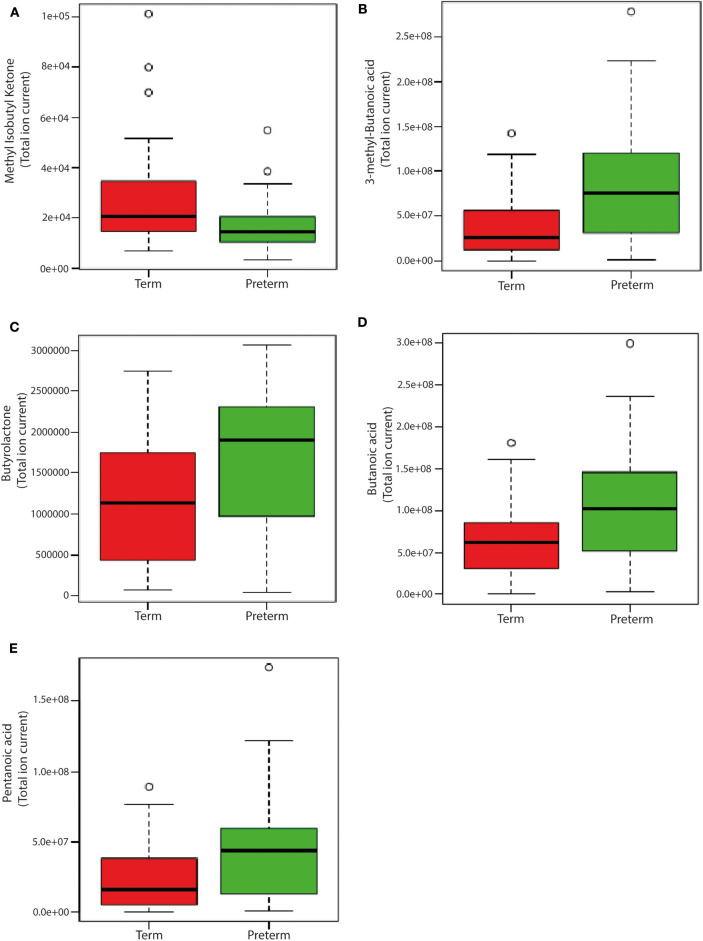
Box-whisker plots of significantly different fecal volatiles in children born very preterm and term. (A) Methyl Isobutyl Ketone (p = 0.0297); (B) 3-methyl-Butanoic acid (p = 0.0297); (C) Butyrolactone (p = 0.0356) (D) Butanoic acid (p = 0.0356); and (E) Pentanoic acid (p = 0.0356). The analysis was performed on MetaboAnalyst 3.0 (a web server for metabolomics data analysis and interpretation) (Xia et al., 2009). Two groups [very preterm (n = 20) and term (n = 21)] were compared using unpaired t-test (Wilcoxon Mann Whitney test) with FDR correction using Bonferroni correction and Holm step-down procedure on MetaboAnalyst 3.0. Fecal volatile data is presented as relative abundance and the measure is the peak area of the most intense ion for that molecule. Unit is given as “total ion current”.